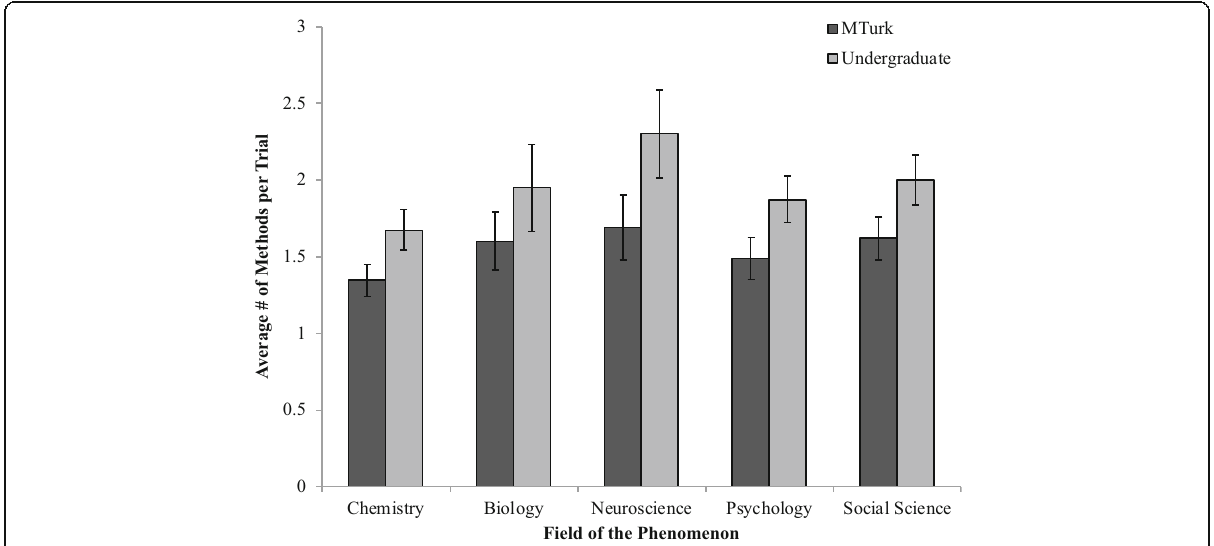
Fig. 4 Average number of methods selected on the all useful methods question by sample and field of the